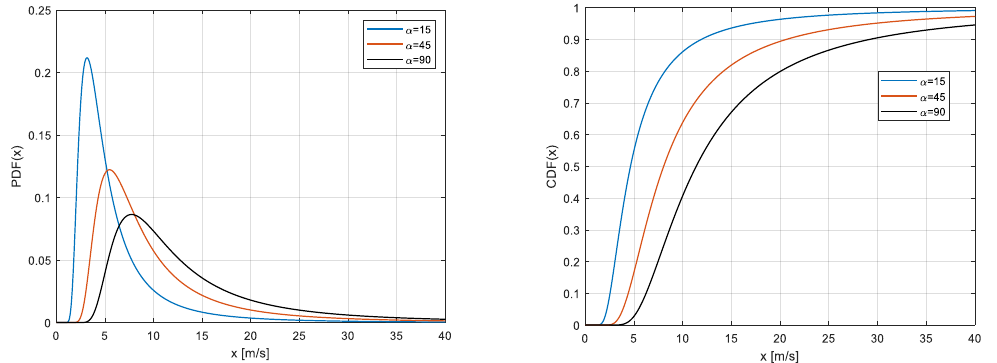
Figure 1. Various inverse Rayleigh PDFs (left) and cumulative distribution functions (CDFs) (right) with three different values of the parameter α.